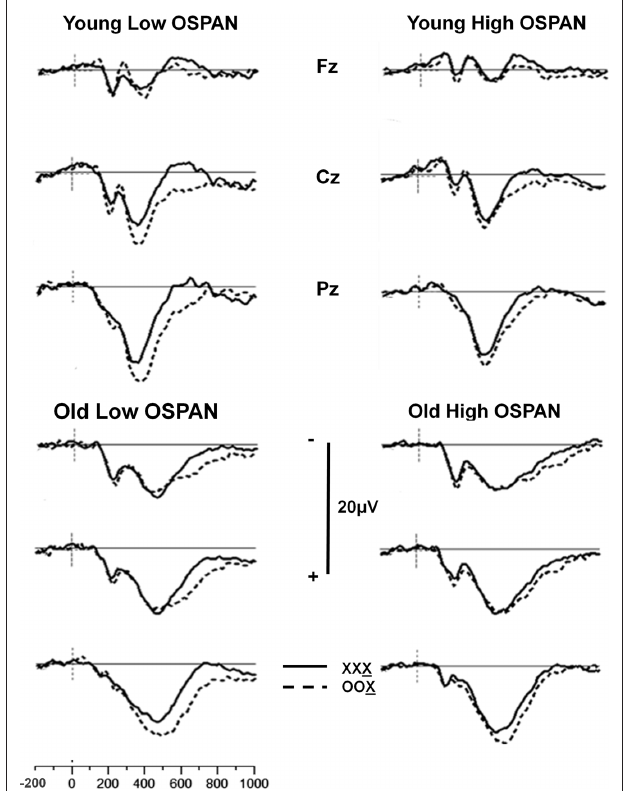
Figure 2 | grand average waveforms of stimulus X as a function of the preceding two stimuli for the Fz, Cz, and Pz electrode sites for younger and older adults split into high- and low OSPAN groups. Solid line: no change condition (XXX, where X is the current stimulus); dashed line: most extreme change condition (OOX, where X is the current stimulus).